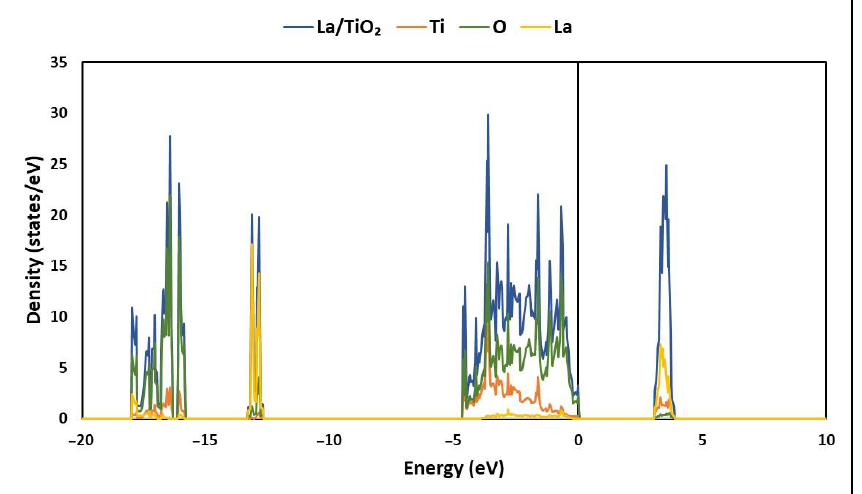
Figure 3. Total density of states (TDOS) of La/TiO 2. The TDOS of La/TiO 2 shows two main regions: a lower region corresponding to the lower valence band (VB), from about − 18 to 0 eV and an upper region corresponding to the upper conduction band (CB) from about 3 to 4 eV. In the Valencia band, it is evident that the main contribution is made by O, while both Ti and La contribute mainly to the conduction band. In the La/TiO 2 structure, the O atom borders the valence band maximum (VBM), while the Ti atom borders the conduction band maximum